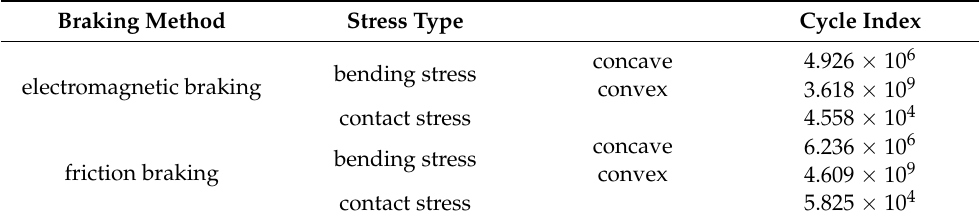
Table 4. Fatigue life of pinion dangerous